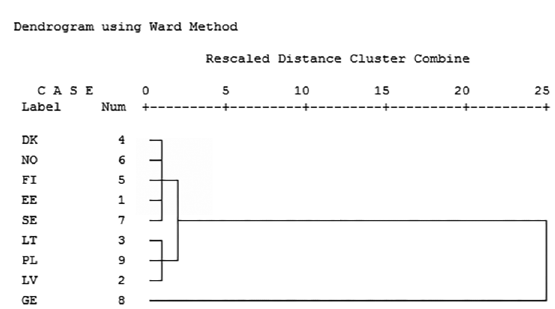
Fig. 4. Dendrogram representing the formation of countries’ clusters based on their railway transport flows during 2008–2009